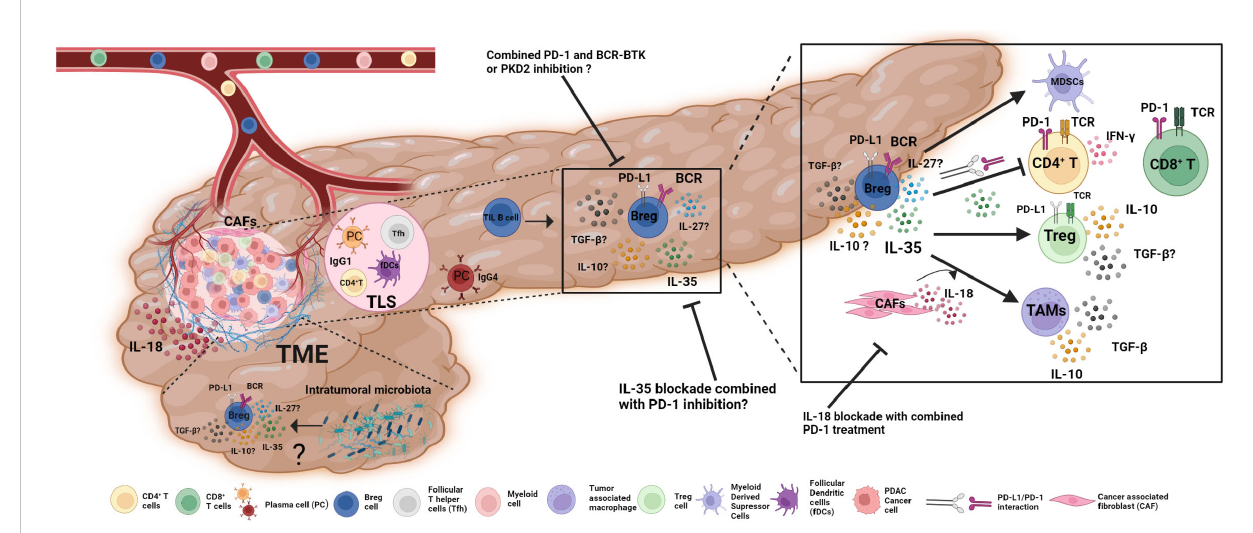
FIGURE 1 The role of Bregs in PDAC TME and potential approaches for Breg-targeted immunotherapies. Immune cells enter PDAC through the bloodstream and develop anti- or pro-tumorigenic characteristics. B cells are highly in fi ltrated PDAC-TME and show dual roles. In tertiary lymphoid structures (TLS); naive B cells that detect tumor-associated antigens differentiate into plasma B cells with the aid of Tfh and fDCs and produce IgG1 to exhibit anti-tumoral immune functions. However, plasma cells scattered within the TME produce an anti-in fl ammatory antibody, IgG4. Bregs are the most prominent B cell subset in PDAC TME, secreting anti-in fl ammatory cytokines IL-35 and IL-10 that boost Tregs, myeloid-derived suppressor cells (MDSCs), and tumor-associated macrophages (TAMs) while restricting the activity of effector CD4 + and CD8 + T cells. Bregs, together with their surface-bound PD-L1, interact with PD-1 on the surface of T lymphocytes to decrease their effector activity. IL-18 production from cancer- associated fi broblasts (CAFs) in fl uences Breg development and function in TAMs. The effects of other factors, such as intra-tumoral microbiota, on Breg differentiation and function, remain unclear. In addition to current treatment options; Breg-targeted immunotherapies, such as a combination of BCR-BTK signaling inhibition or IL-18 and IL-35 blockade with immune checkpoint inhibitors, might be promising approaches for PDAC immunotherapy in addition to existing